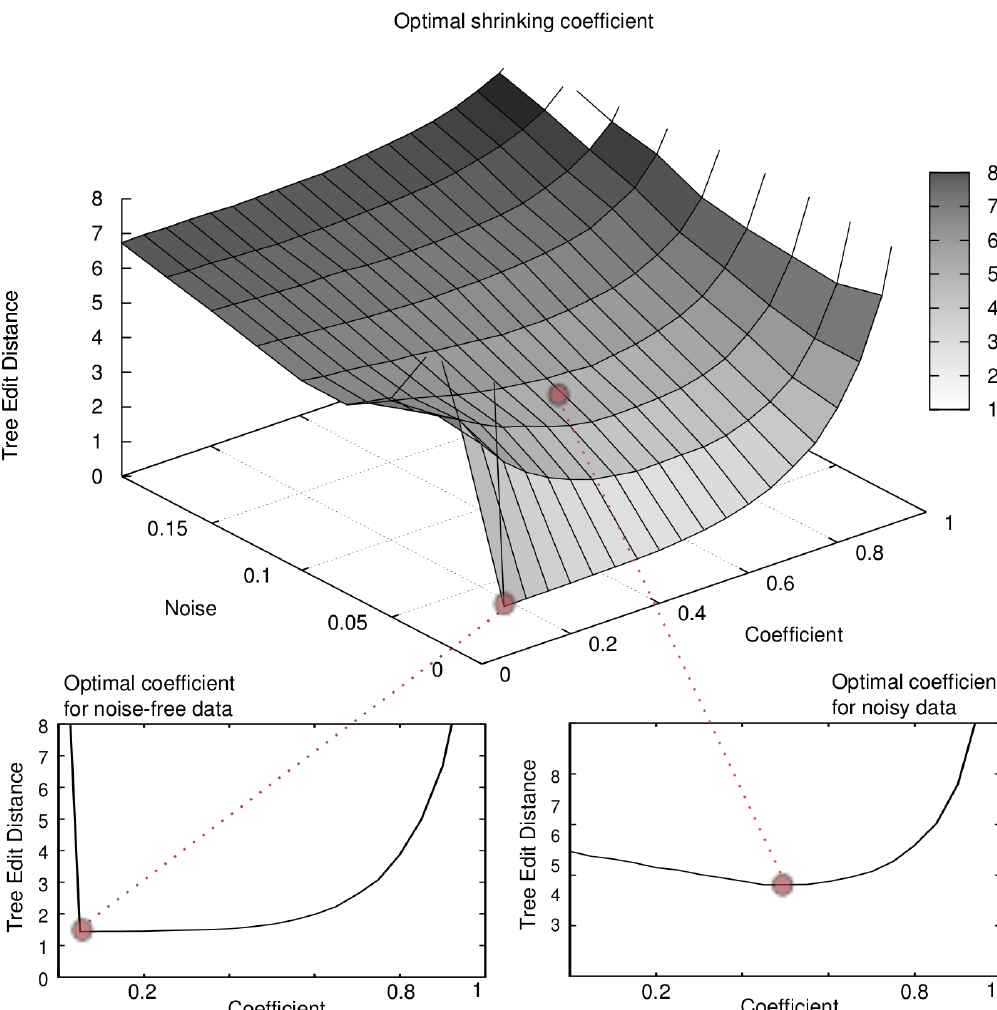
Figure 2. Optimal shrinkage-like coefficient for reconstruction performance. We show here the performance in the reconstruction of trees (TED surface) with n ~ 150 samples as a function of the shrinkage-like coefficient l . Notice the global optimal performance for l ? 0 when n ? 0 and for l & 1 = 2 when n w 0 .